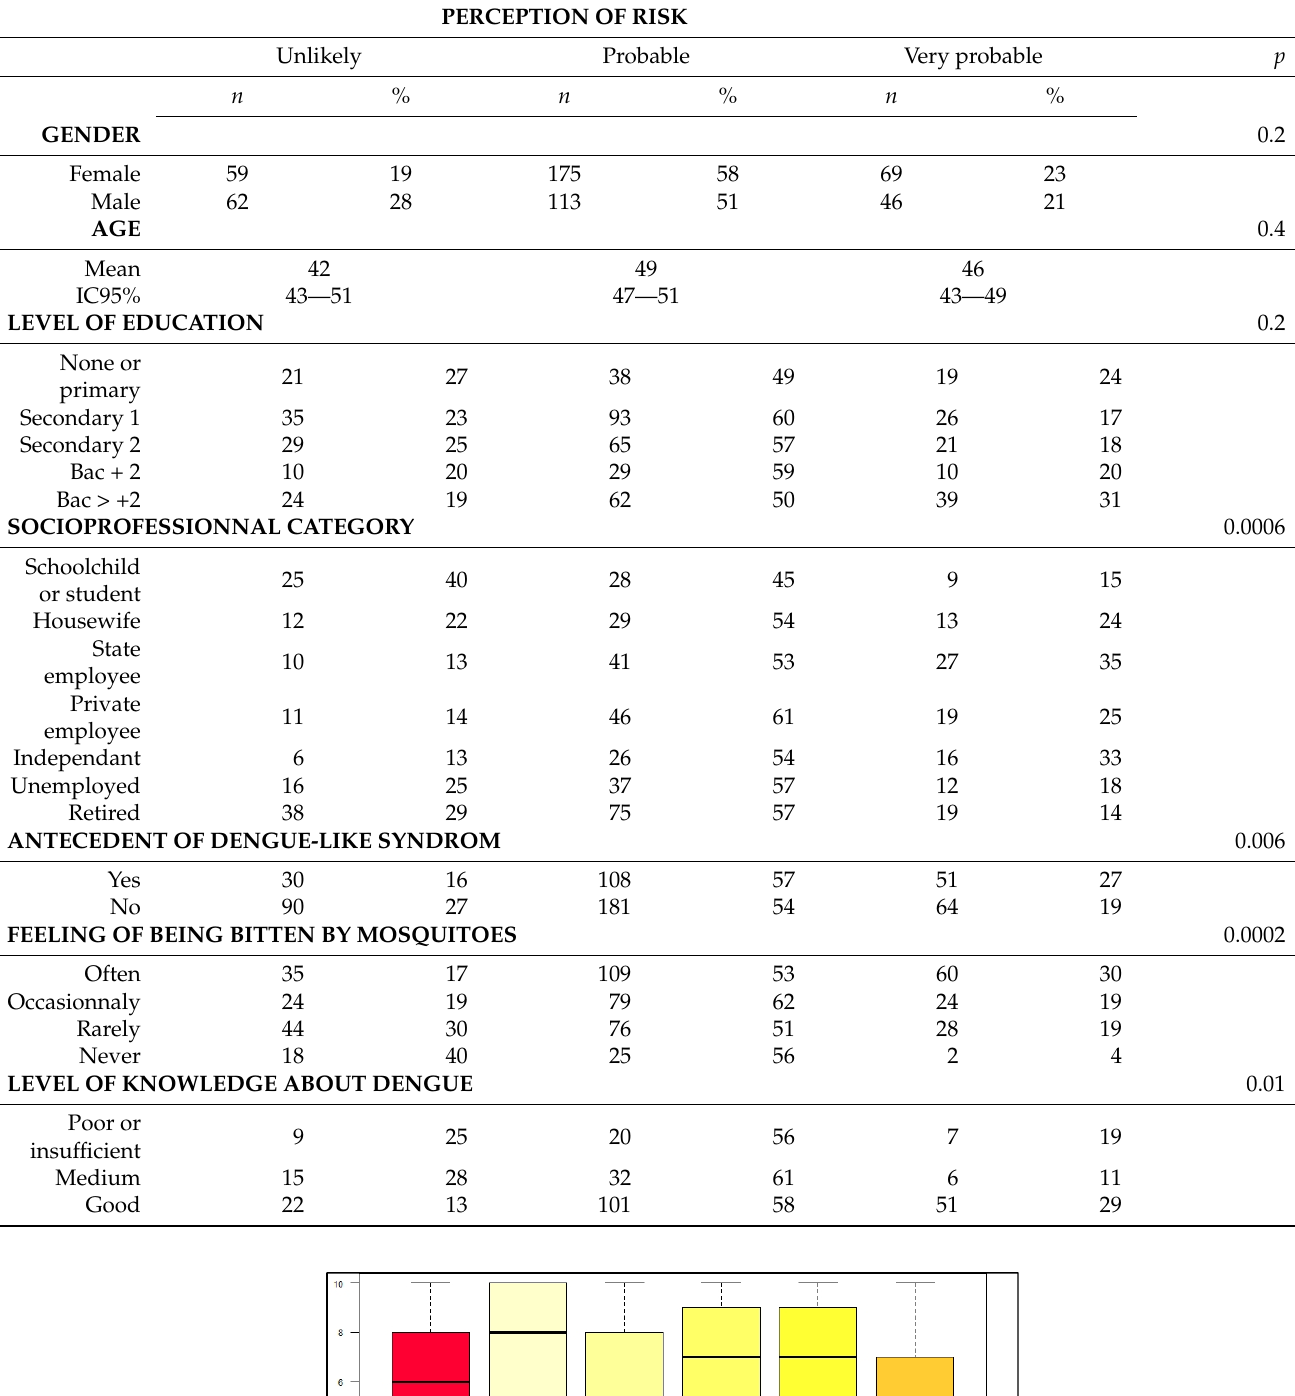
Table 3. Cross analysis between socio-demographic factors, previous experience of a dengue-like symptoms, level of knowledge about dengue, and perception of risk. PERCEPTION OF RISK